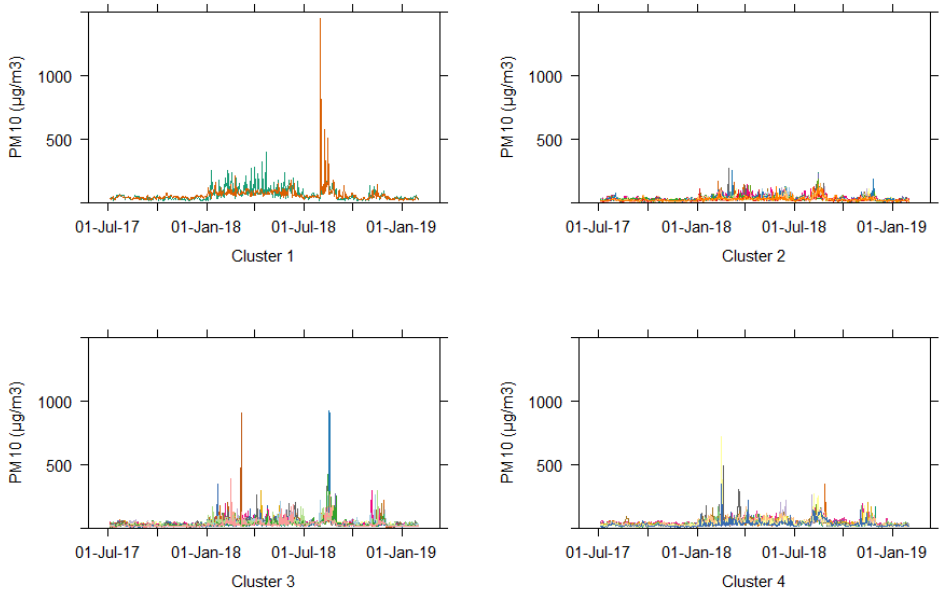
Figure 16. Time series plots for each cluster formed based on DTW and FKM for daily maximum PM 10 time series data.